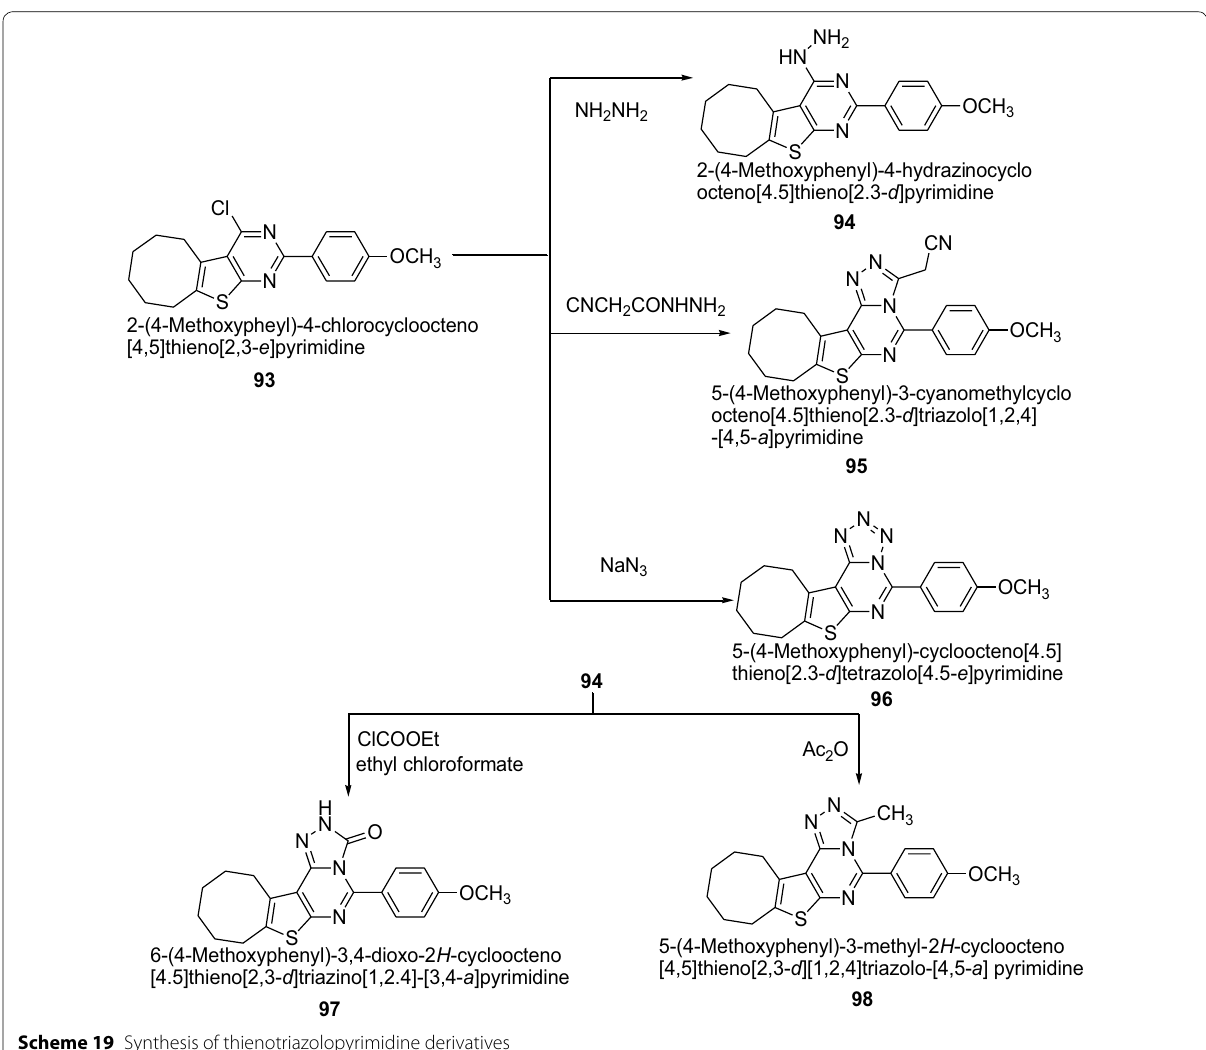
Table 21 Anti-inflammatory activity of the synthesized compounds